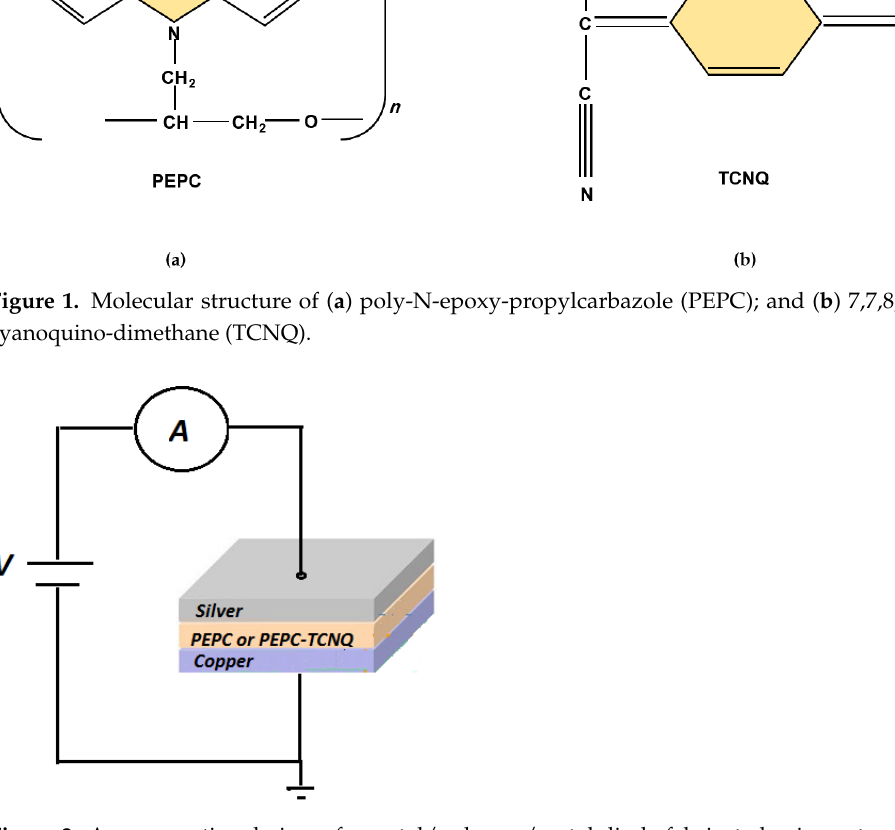
Figure 2. A cross-sectional view of a metal/polymer/metal diode fabricated using p-type PEPC, with or without TCNQ, as a Cu/PEPC/Ag- and Cu/PEPC-TCNQ/Ag-based memory device; for forward bias, the positive and negative terminals of the battery were connected to the top (Ag) and bottom (Cu) electrodes, respectively, for both devices.